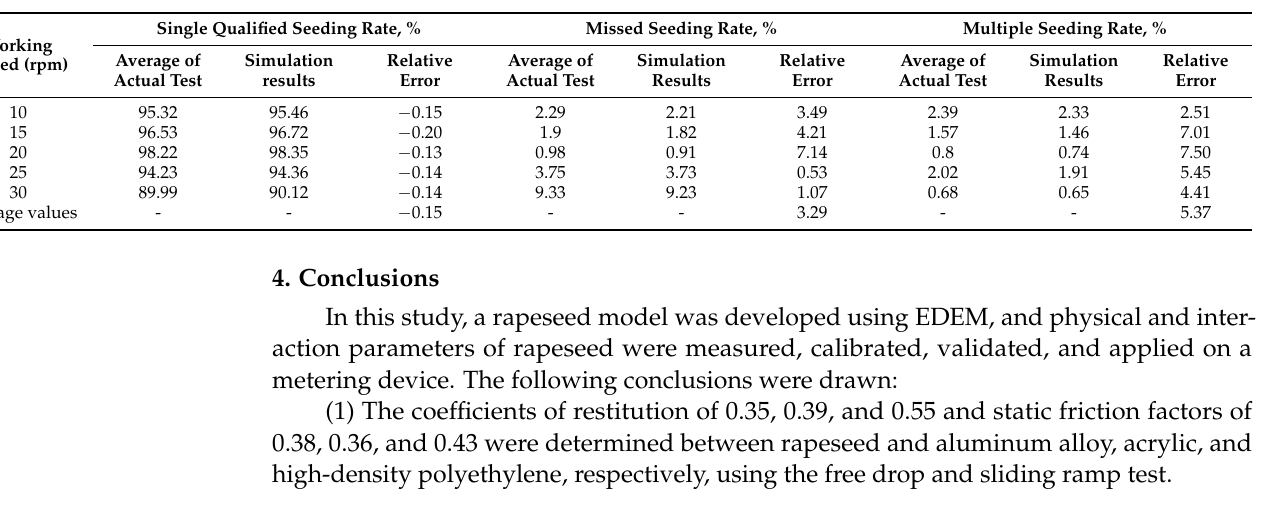
Figure 10. Comparison of simulation results with real test results. ( a ) Seeding qualification of simulation; ( b ) Miss seeding of simulation; ( c ) Multiple seeding of simulation; ( d ) Actual seeding situation of the metering device. Table 8. Results of the validation tests.